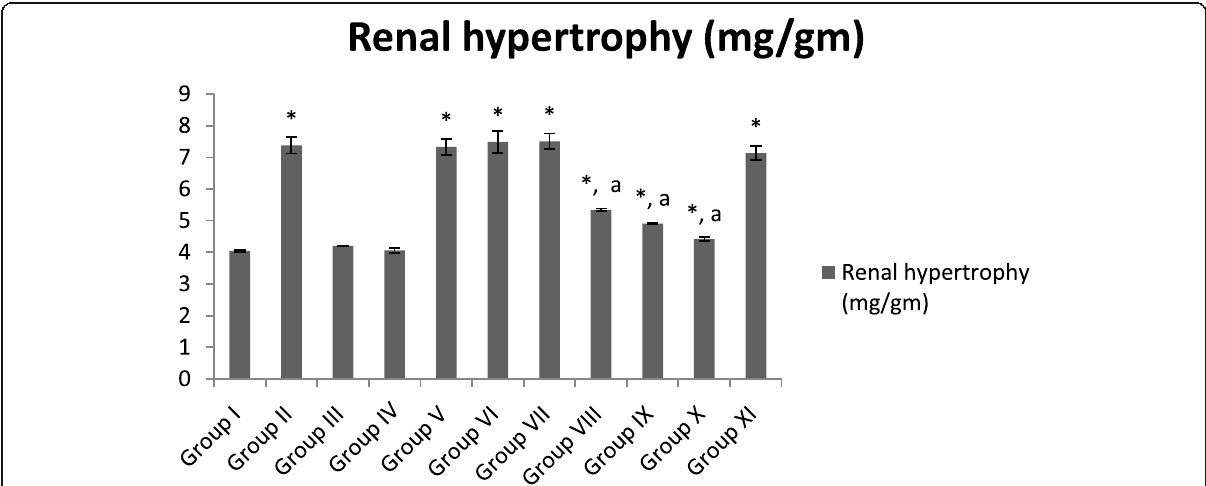
Fig. 6 Graph representing renal hypertrophy levels (mg/gm). All values were represented as mean ± SEM. *= p < 0.005 versus group I (normal control); a = p < 0.005 versus group II (uninephrectomised diabetic control)